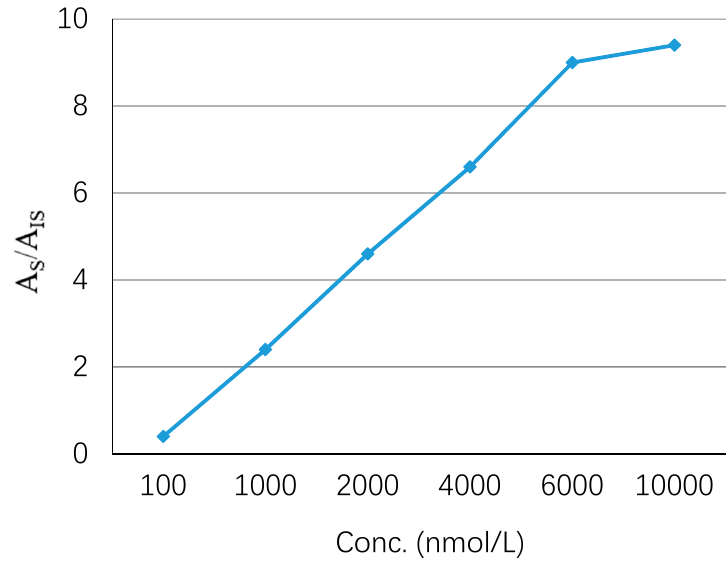
Figure 4. Capacity of GO-Tabs.